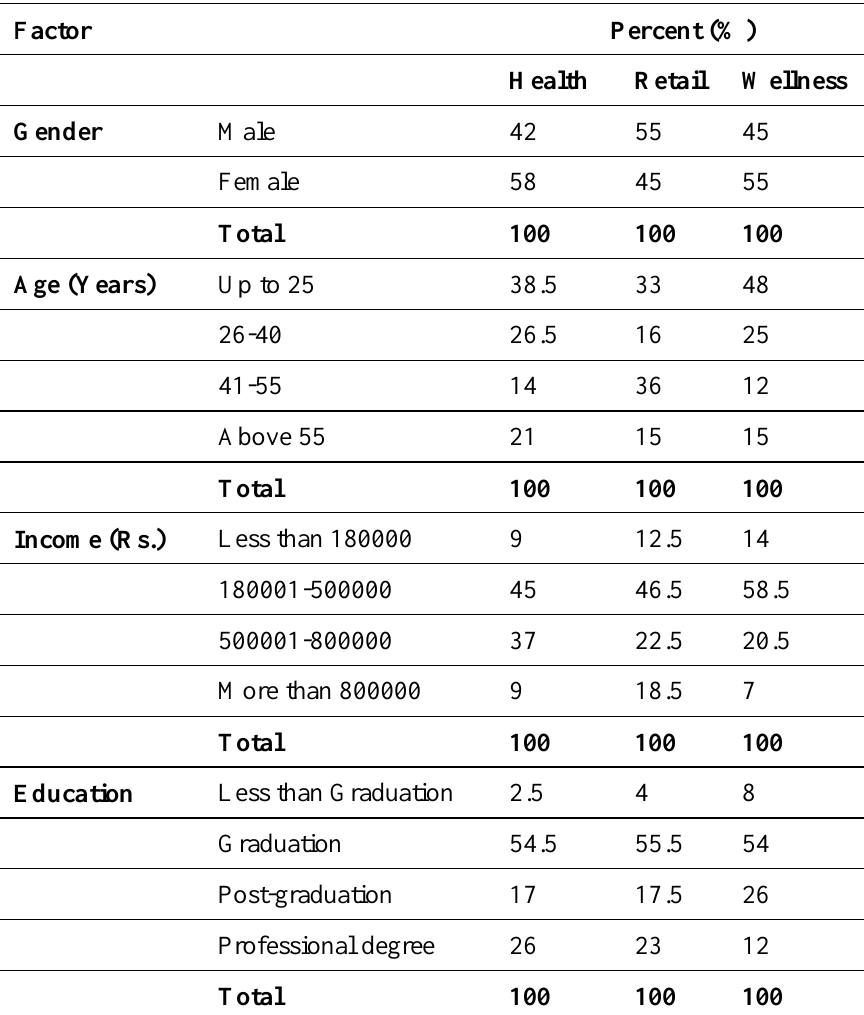
Table 01: Sample Profile